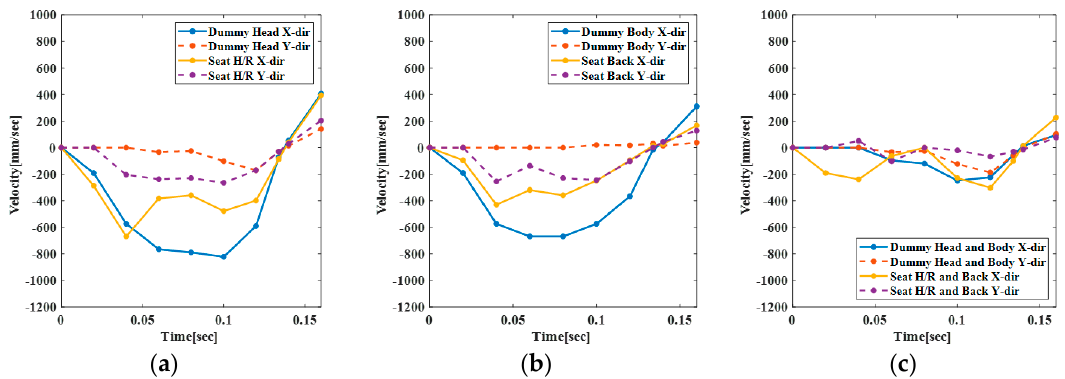
Figure 7. Velocities of active headrest seat and dummy in the x - and y -directions: ( a ) velocity of head and headrest; ( b ) velocity of dummy and seat; ( c ) relative velocity of dummy and seat.